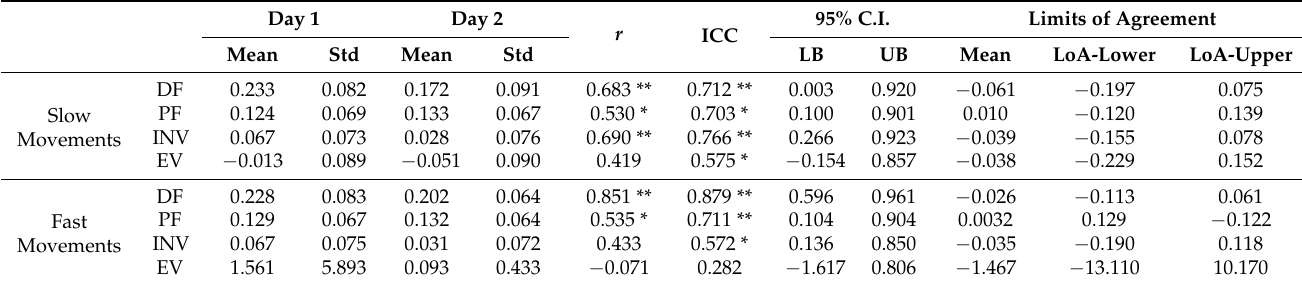
Table 1. Intraclass correlation coefficients (ICC) between day 1 and day 2 on ankle stiffness for four ankle movements of 20° dorsiflexion (DF), 20° plantar flexion (PF), 12° inversion (INV), and 12° eversion (EV) using the ankle movement trainer (AMT). Ankle angular velocity was 2.14°/s for slow movement and 9.77°/s for fast movement